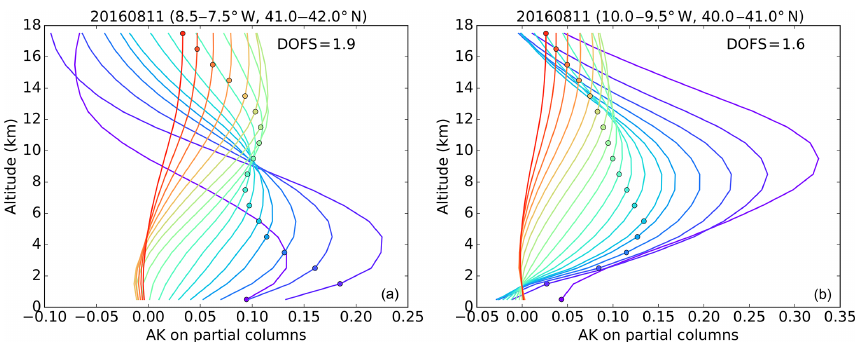
Figure 7. Averaging kernels (AKs) representing the vertical sensitivity of CO profiles retrieved from the IASI/MetOp-A daytime observations over land in Portugal (a) and the ocean off the coast of Portugal (b)